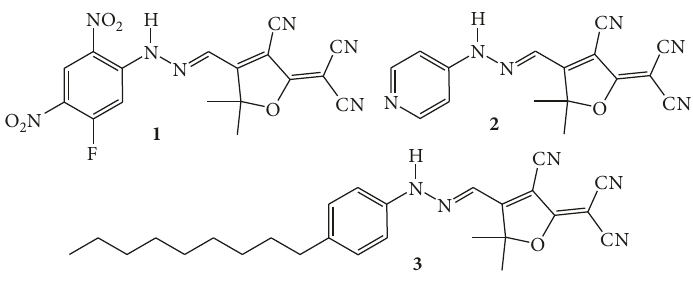
Figure 1: Hydrazone dyestuffs 1 – 3